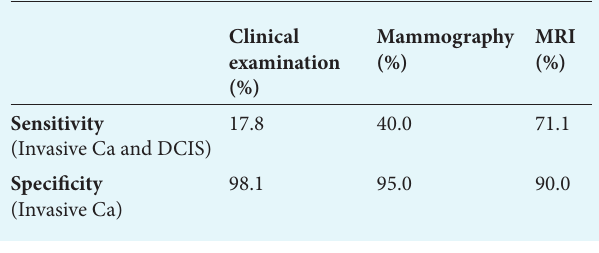
Table 2. American Cancer Society Guidelines for Breast Screening with MRI as an adjunct to mammography, 2007